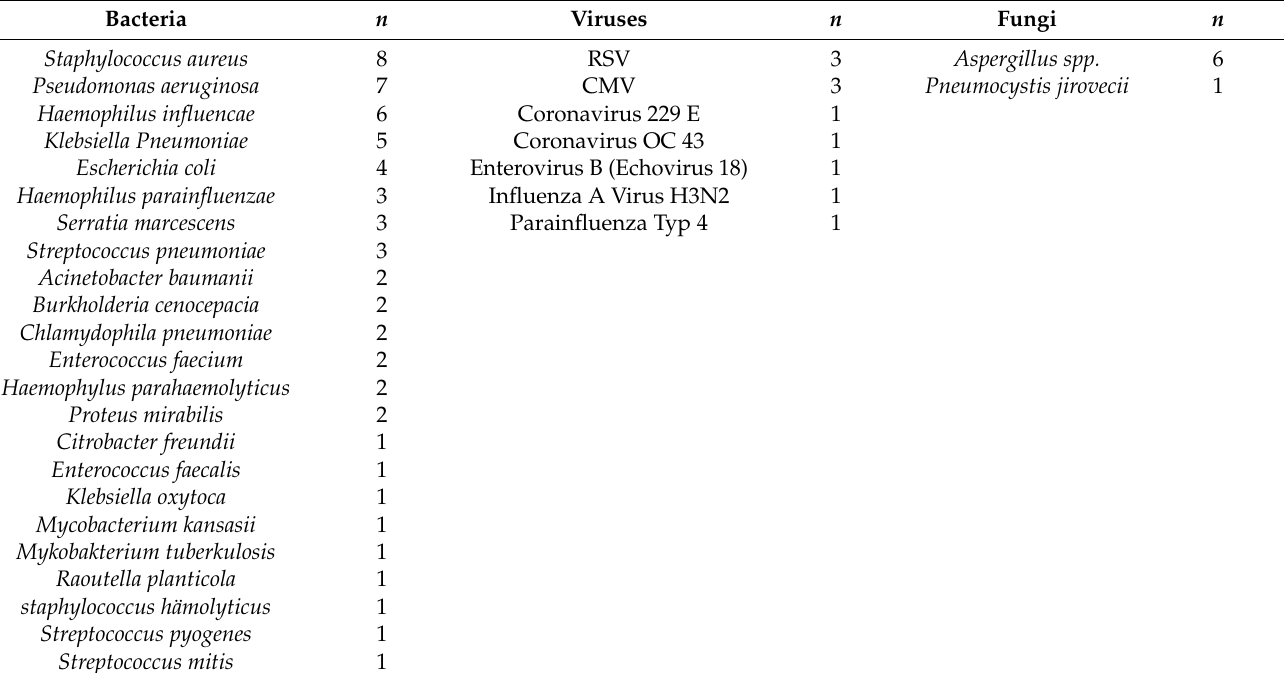
Table 3. Distribution of co-infecting pathogens.